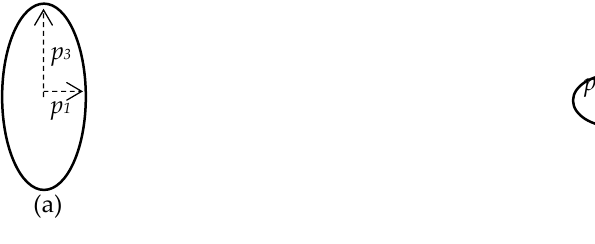
Figure 1. ( a ) Quasi-transverse wave; ( b ) Quasi-longitudinal wave.